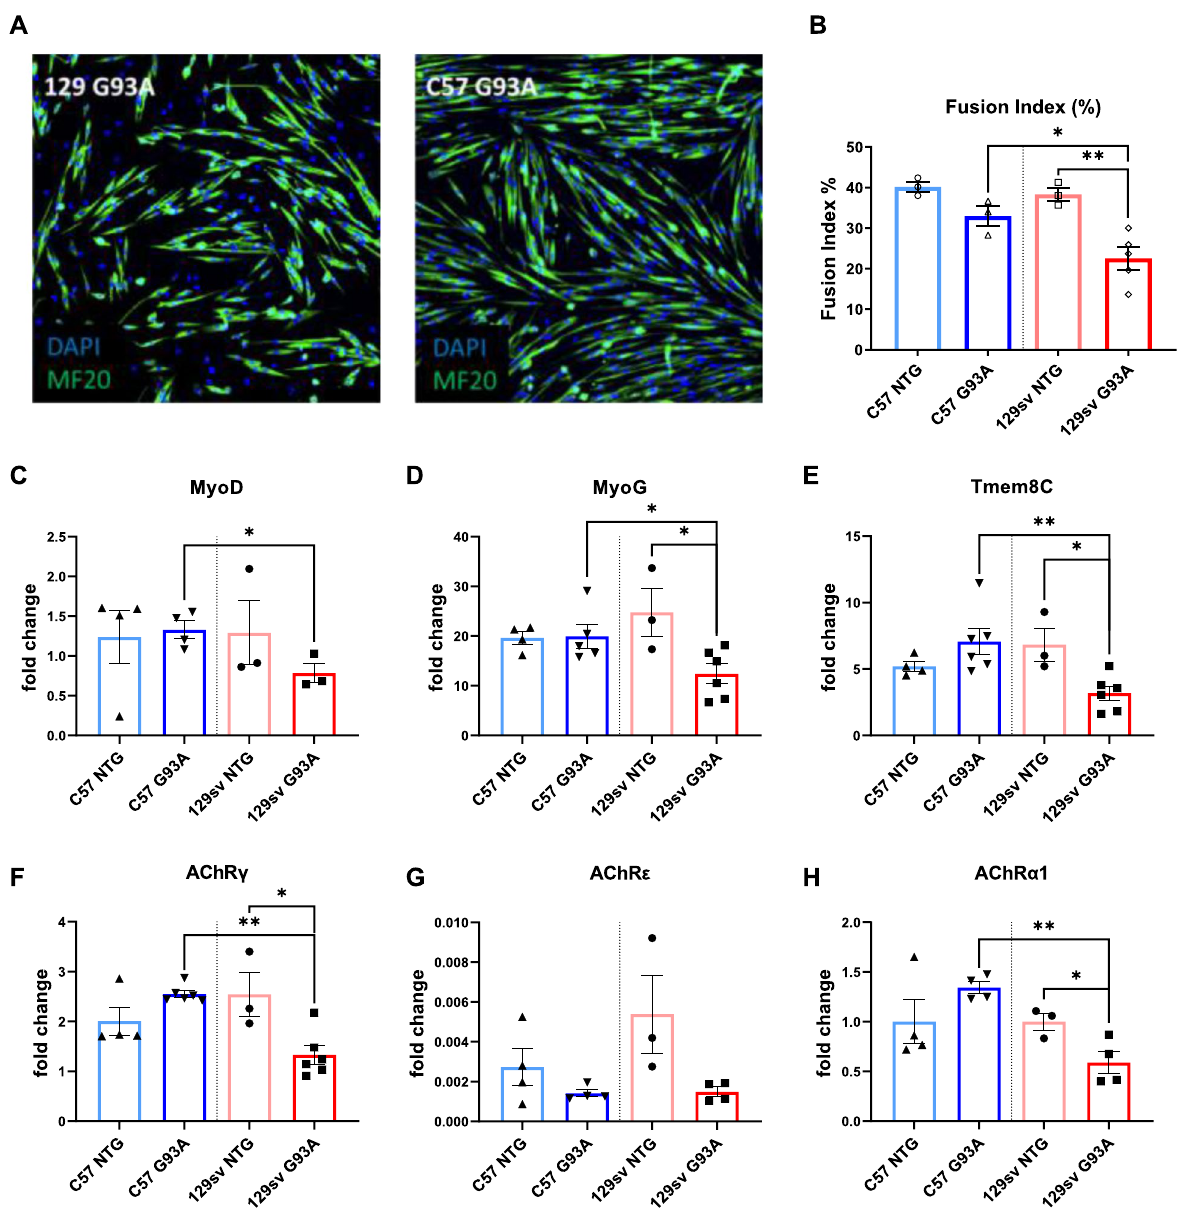
Fig. 6 Ex vivo muscle derive satellite cells differentiate fast from slow-progressing mice. A Representative confocal images showing the immunostaining for MF20-MyHC (green) and DAPI (blue) on primary satellite cell (SC) cultures of C57SOD1 G93A and 129SvSOD1 G93A mice in differentiating medium (DM) for 48 h, compared with NTG littermates ( n 3). Scale bar 100 μm. B The fusion index was calculated as (no. of = = nuclei present in MyHC + cells with two or more nuclei/no. myotubes. Data are reported by means SEM. Significance was calculated with one-way ± ANOVA with uncorrected Fisher’s LSD post-analysis (* p 0.05, ** p 0.01). C–I Real-time qPCR for MyoD ( C ), MyoG ( D ), Tmem8c ( E ), AchRγ ( F ), ≤ ≤ AchRε ( G ), AchRα1 ( H ) transcripts in the primary SC cultures of C57SOD1 G93A and 129SvSOD1 G93A mice compared with NTG littermates ( n 3–6). = Data are expressed as the mean ( SEM). Significance was calculated with 2-tailed Student’s t -test ( p 0.05; ** p ± ≤ ≤